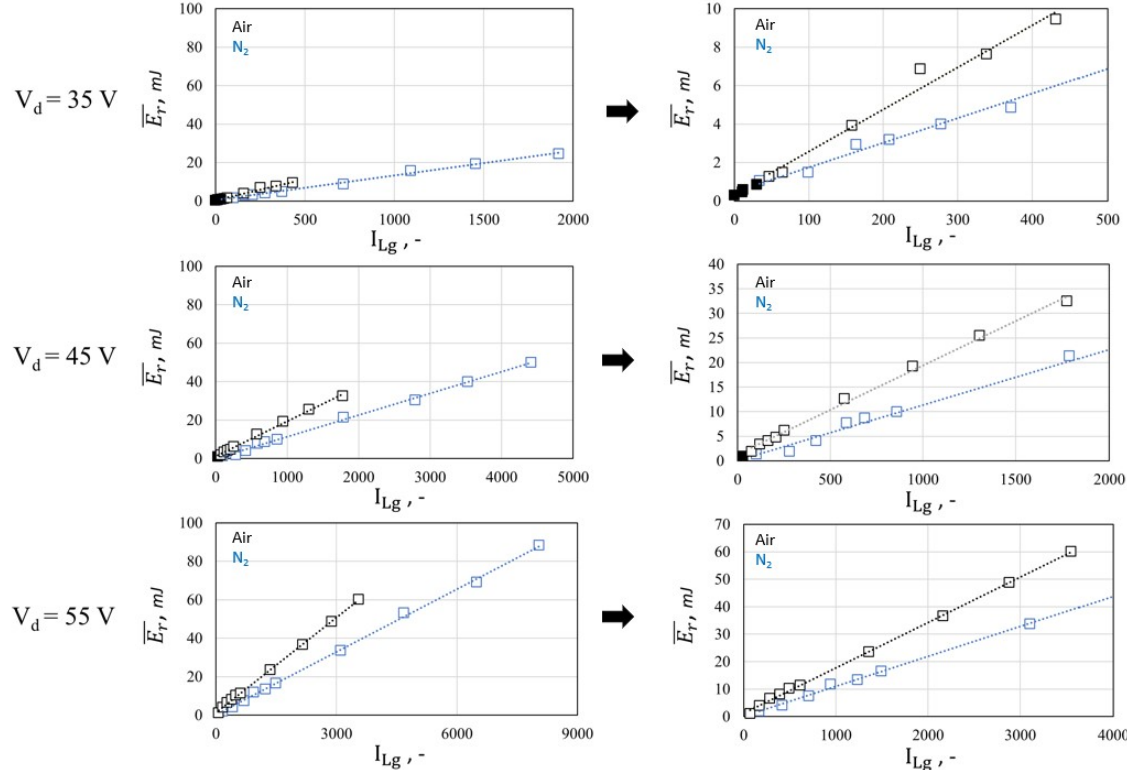
Figure 15. Correlation between E r and I Lg in N 2 (blue markers) and synthetic air (black markers) plotted against each activation time at the three voltage levels investigated. Left-hand side graphs report energy and luminosity data concerning the whole analyzed range and their linear fits (black and blue dashed lines). Plots on the right-hand side represent a magnification around the origin of the trend seen on the left-hand side.